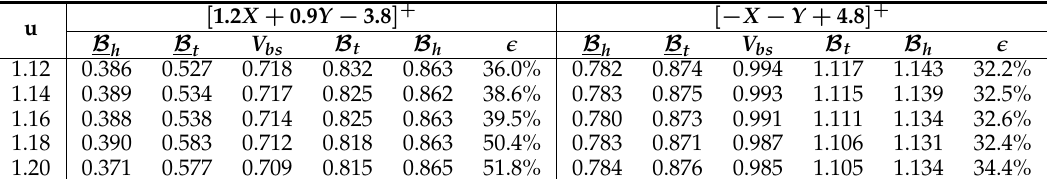
Table 1. Sensitivity of Valuation Bounds Against Jump Size. The time-zero prices of the exchange rates X and Y are 1.6 and 2.5. The volatilities of the processes X and Y are 42%, and two processes are correlated with ρ = 0.20. Both the domestic and foreign interest rate are zero. All prices are attained within a price mesh of J = 30. Two basket options mature at T = 1 (year).